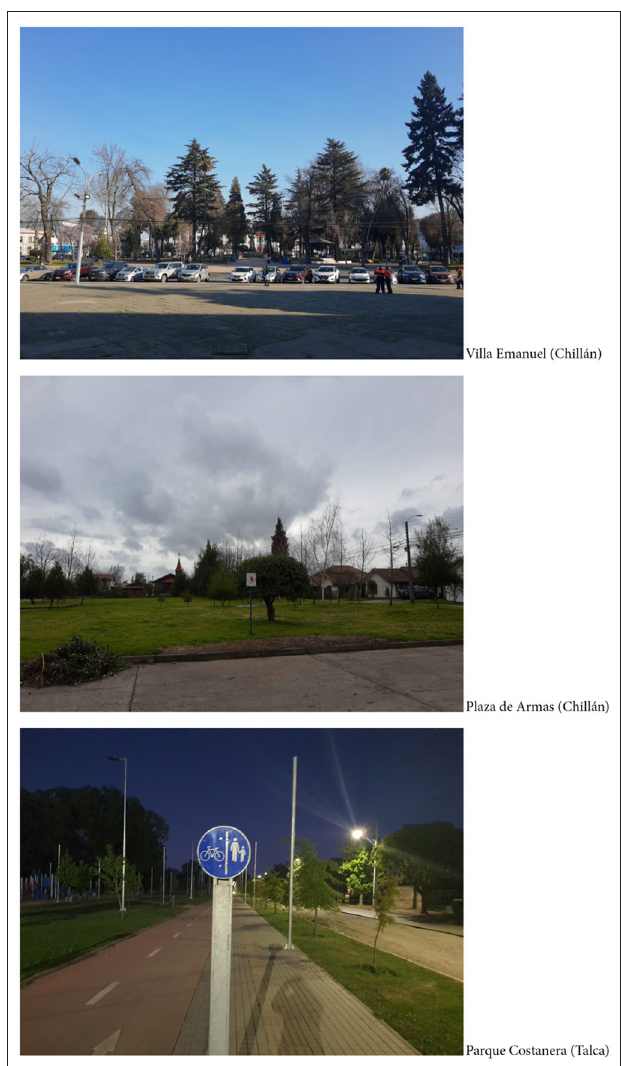
FIGURE 9 | Photographs of green areas in the two cities: (1) Villa Emanuel and (2) Plaza de Armas are the most mentioned urban green spaces in Chillán. In Talca, the most mentioned green space is (3) Parque Costanera (see the map in Figure 8 for location